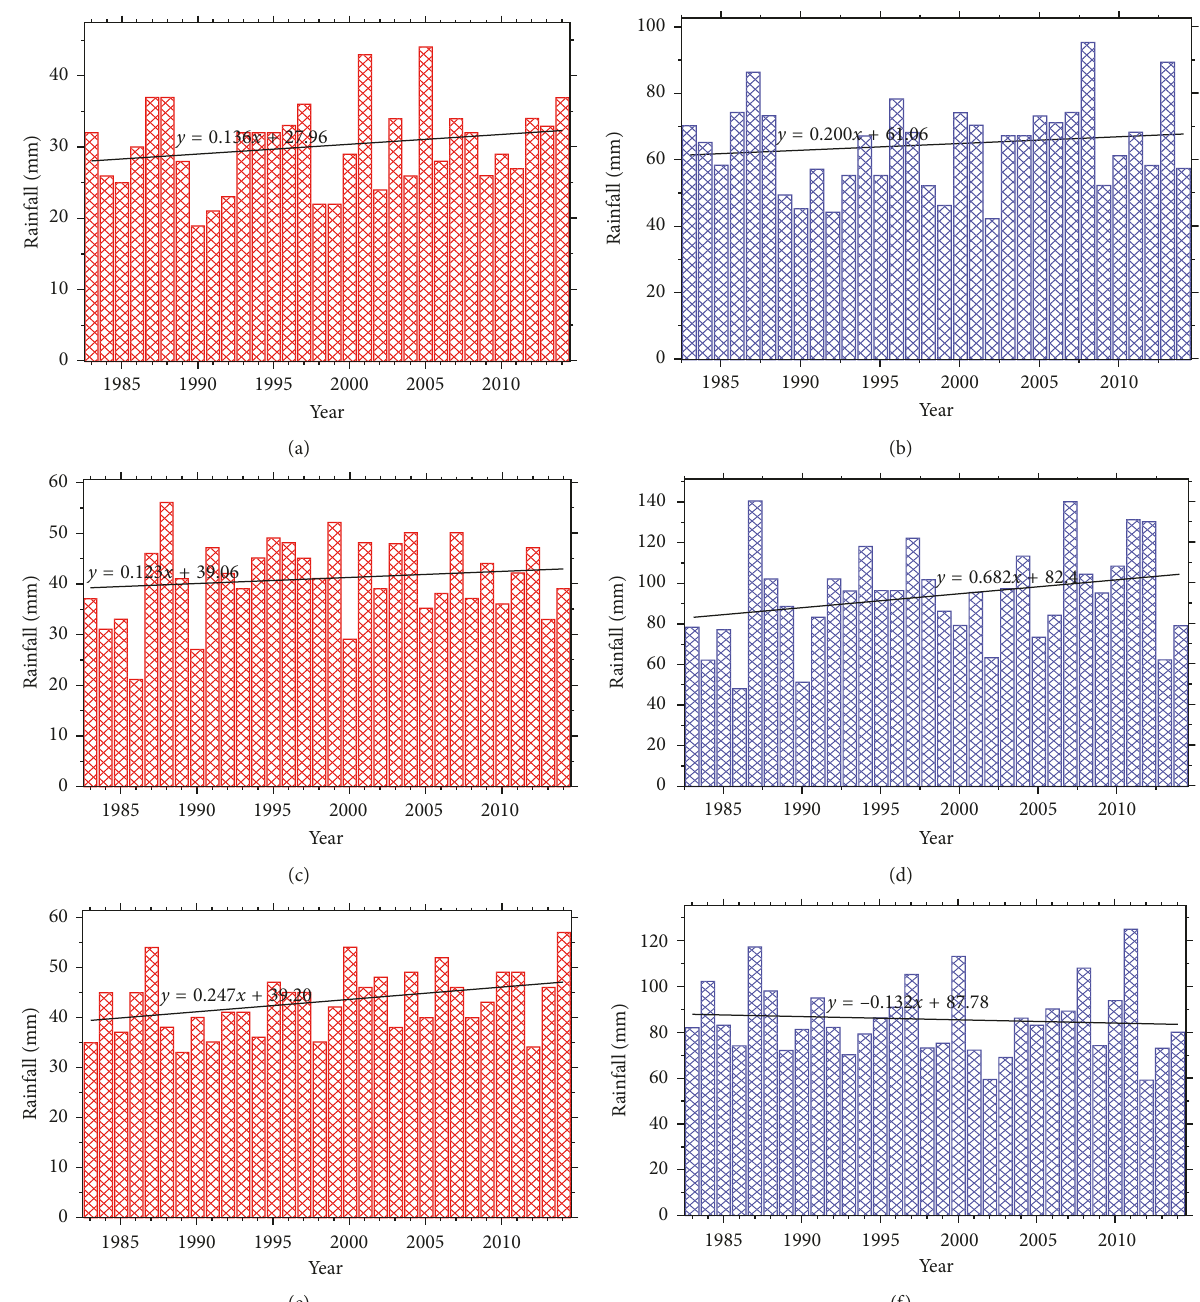
Figure 10: Trends of maximum 1-day precipitation (RX1day) over three agroecological zones, (a) lowland, (c) midland, and (e) highland, and for maximum 5-day precipitation (RX5 day), (b) lowland, (d) midland, and (f) highland, for the period